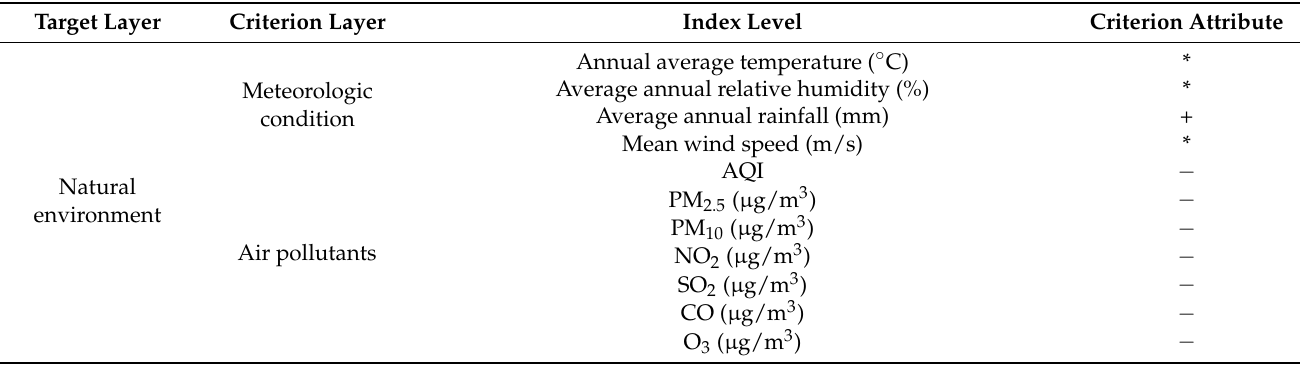
Table 3. Evaluation indicators and comprehensive weight of human settlements based on air quality from 2013 to 2018. Target